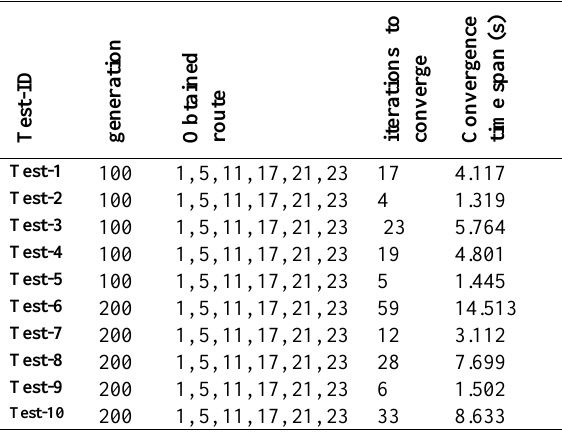
Table 1. Convergence history of MGA in robotic scenario